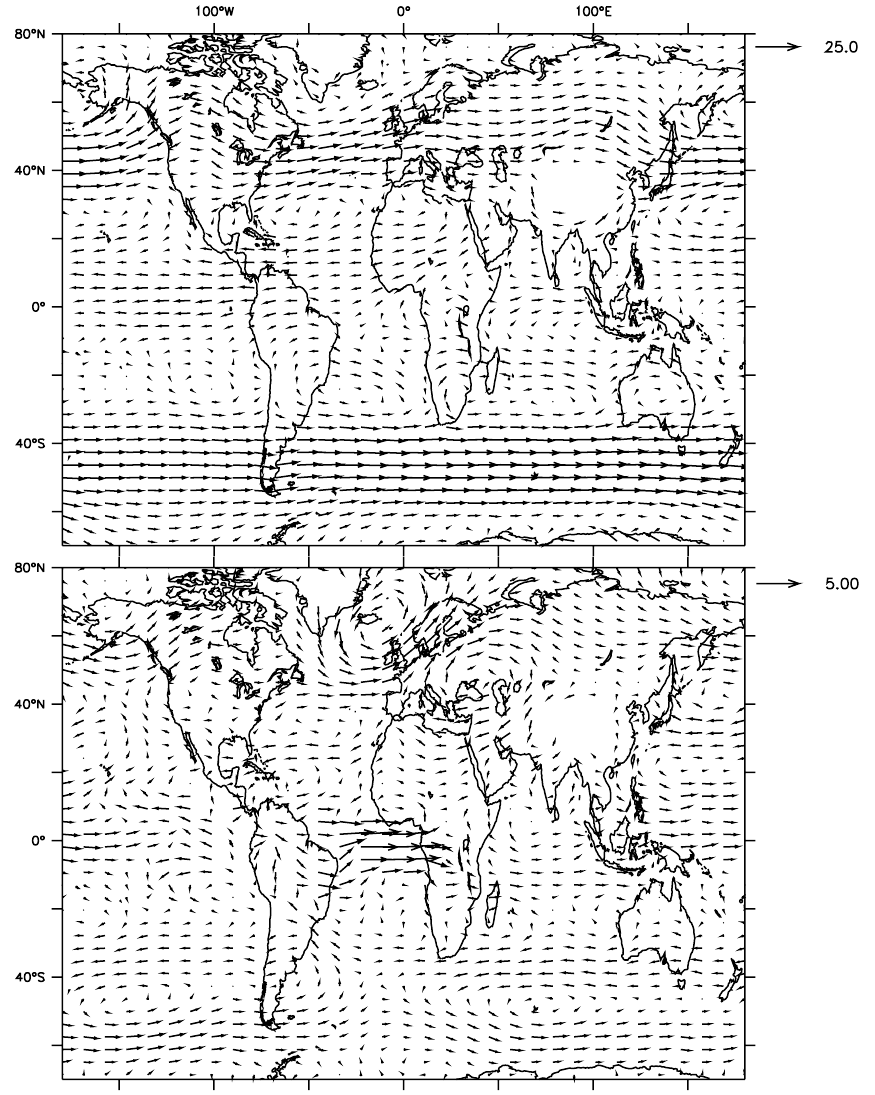
Fig. 10. Wind velocity (ms − 1 ) at 800mbar for the Control (100-year average, top) and the anomaly at years 97–106 in 1.0NA (bottom). The reference vector is 25ms − 1 for Control and 5ms − 1 for the 1.0NA